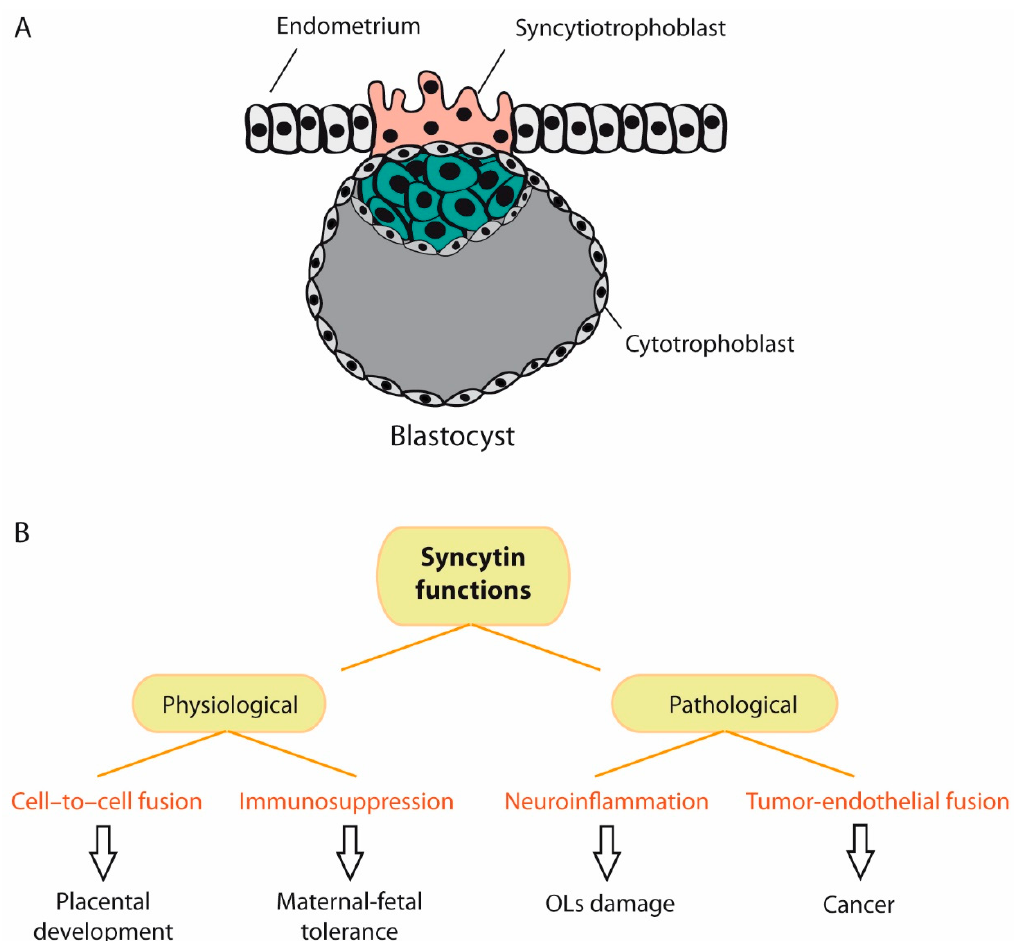
Figure 5. Physiological and pathological functions of syncytin. ( A ) When the embryo reaches the blastocyst stage, it undergoes implantation into the endometrium of the uterine wall. During implantation, the trophoblast (cells that form the outer layer of the blastocyst) develops into two layers: the cytotrophoblast and syncytiotrophoblast. The syncytiotrophoblast invades the maternal endometrium and directly contacts the maternal capillaries. Syncytin-1 plays a major role in syncytiotrophoblast cell fusion and, therefore, in embryonic development. ( B ). Besides cell-to-cell fusion, syncytin-1 exerts an immunosuppressive function that inhibits rejection of the fetus by the maternal immune system. However, syncytin-1 exerts also pathological functions, such as neuroinflammation and tumor-endothelial cell fusion. (OLs = oligodendrocytes).